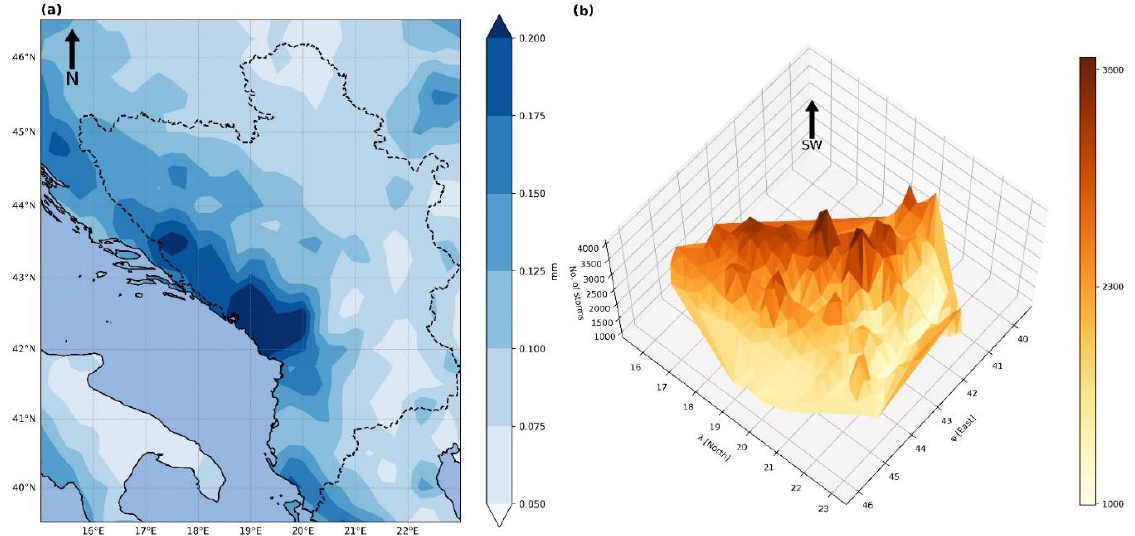
Figure 3. ( a ) Distribution of hourly mean precipitation across the study area ( b ) 3D model of the cumulative number of erosive rainfall events for the total study period 1991 – 2020.